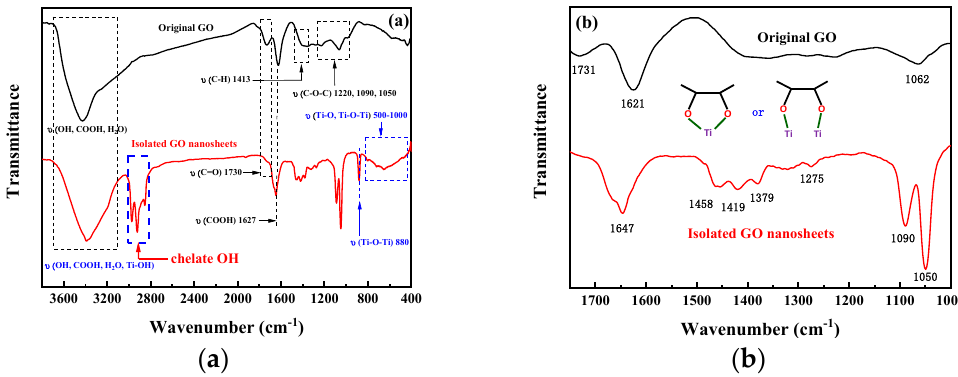
Figure 5. ( a ) the whole and ( b ) partial FTIR spectra of original prepared GO powder and isolated GO nanosheets.